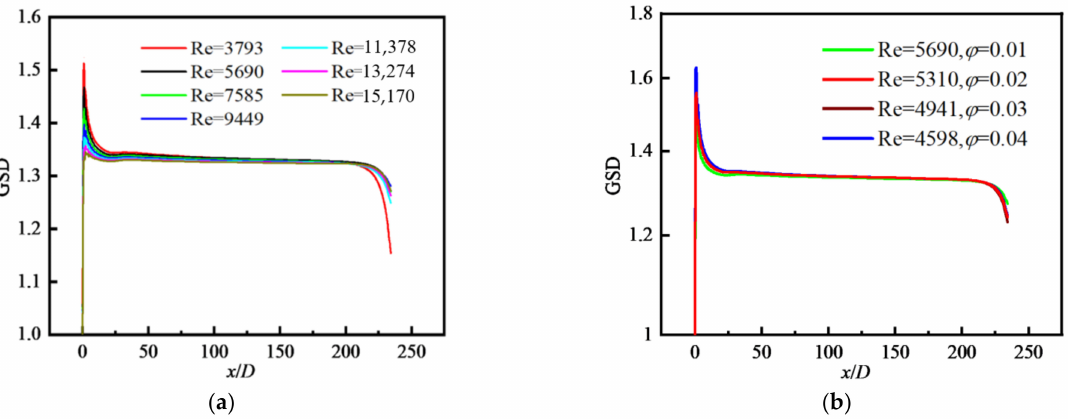
Figure 11. Distribution of GSD along the flow direction with different ϕ : ( a ) ϕ = 0.01; ( b ) at fixed Re and ϕ .